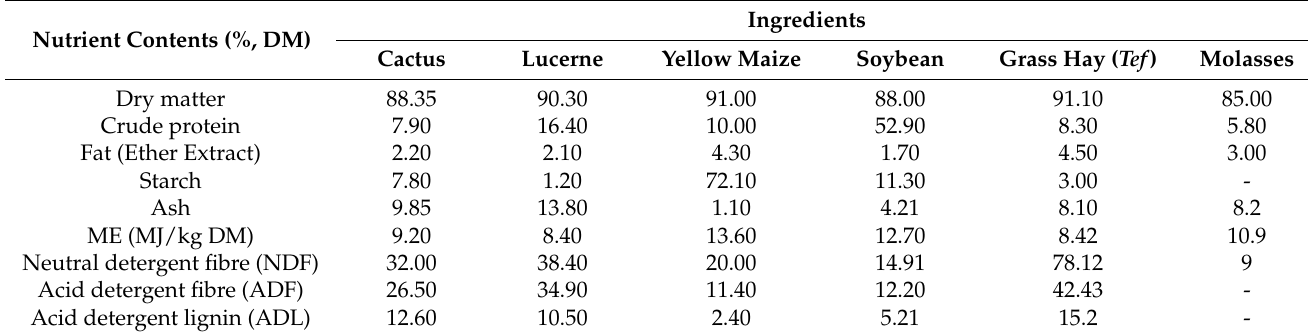
Table 2. The chemical composition of the ingredients used in formulation of experimental